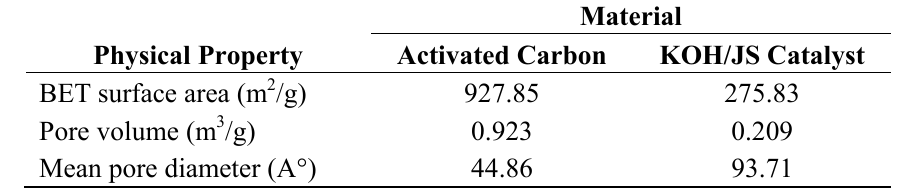
Table 2. The physical properties of activated carbon and KOH/AC (AC = Activated Carbon)